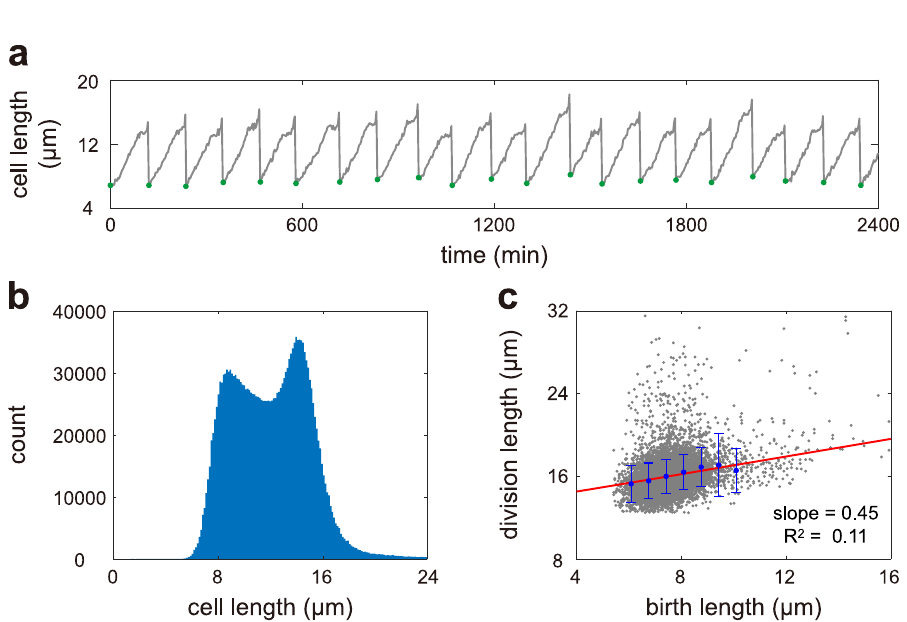
Fig 1. Cell size dynamics in fission yeast. A : Single-cell time-course data of cell size along a typical cell lineage cultured in the yeast extract medium at 34˚C. Here the size of a cell is characterized by its length. The data shown are published in [4]. The green dots show cell sizes at birth. B : Histogram of cell sizes along all cell lineages. The cell size distribution of lineage measurements has a bimodal shape. C : Scatter plot of the birth size versus the division size and the associated regression line. When plotting B, C, we use the data of all 1500 cell lineages cultured in the yeast extract medium at 34˚C, each of which is recorded every 3 minutes and is typically composed of 50 − 70 generations. The generation time is 114 ± 23